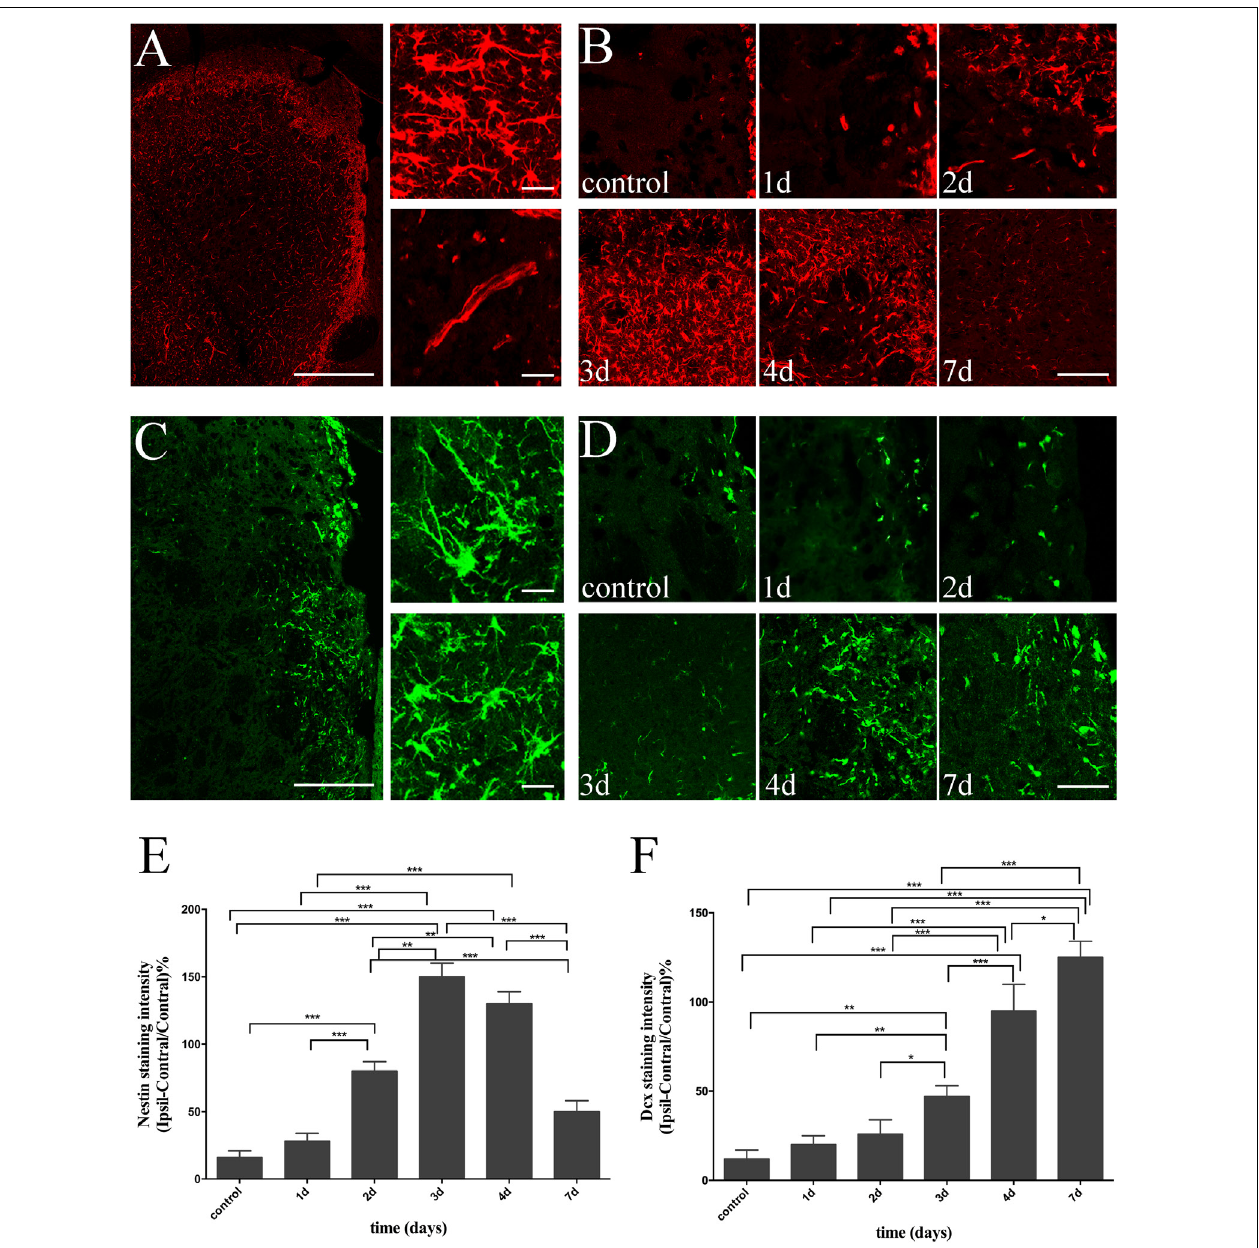
FIGURE 3 | Temporal evolution of NSCs and immature neurons in ischemic STR. (A) The “photomerged” image shows the location of Nestin (+) cells in ischemic STR. The corresponding right panel presents × 20 magnification images of branched and vessel-like NSCs respectively. Scale bar = 100 and 20 µ m. (B) Immunostaining of Nestin before and at day 1, day 2, day 3, day 4 and day 7 after MCAO. Scale bar = 50 µ m. (C) The “photomerged” image shows the location of Dcx (+) cells in ischemic STR. The corresponding right panel presents × 20 magnification images of immature neurons be characteristic of elongated processes or riches in processes in different directions respectively. Scale bar = 100 and 20 µ m. (D) Immunostaining of Dcx before and at day 1, day 2, day 3, day 4, and day 7 after MCAO. Scale bar = 50 µ m. (E) Quantification of Nestin fluorescence intensity in ischemic STR. ∗∗∗ P < 0.001 versus day 2, day 3, day 4 and control, day 1, day 7. ∗∗ P < 0.001 versus day 2 and day 3, day 4. (F) Quantification of Dcx fluorescence intensity in ischemic STR. ∗∗∗ P < 0.001 versus day 4, day 7 and control, day 1, day 2, day 3. ∗∗ P < 0.01 versus day 3 and control, day 1. ∗ P < 0.05 versus day 3 and day 2. ∗ P < 0.05 versus day 7 and day